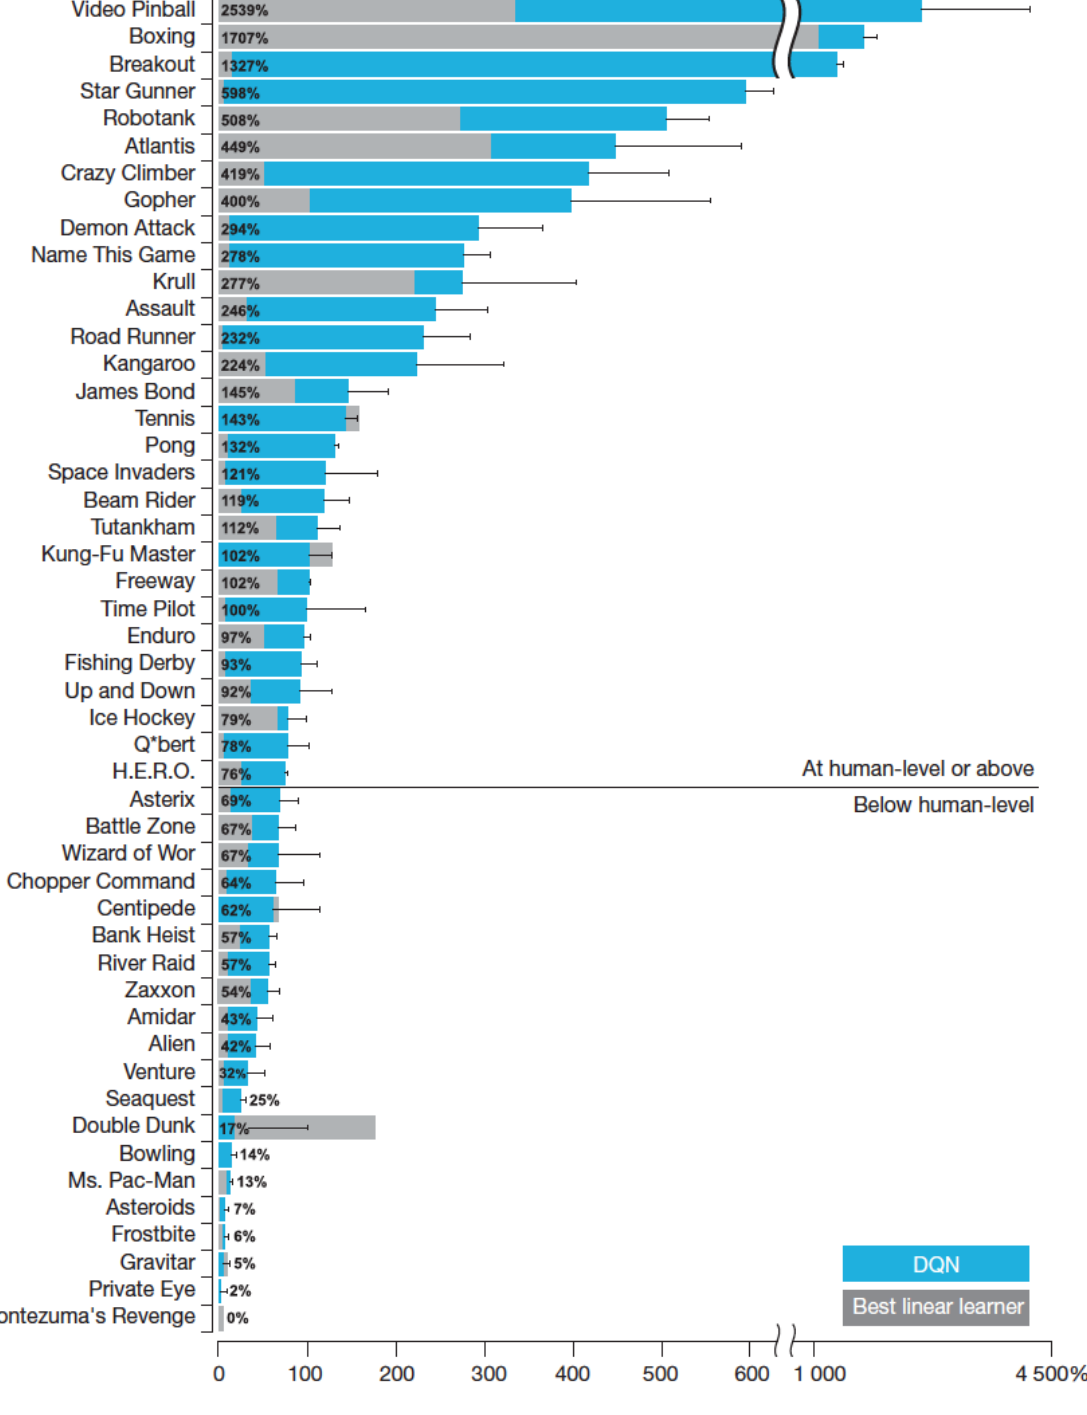
Figure 13. Performance of the DQN agent in ATARI games